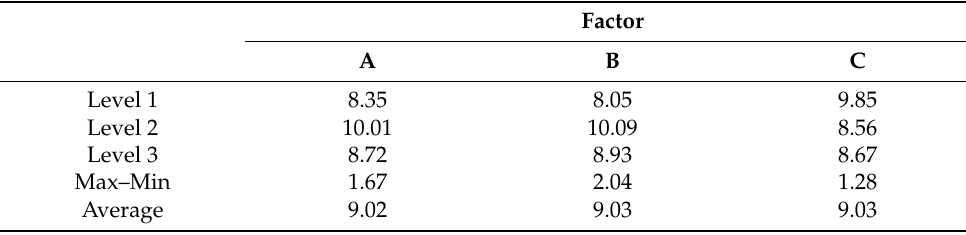
Figure 3. Surface texture of the sidewall of the microfluidic channel EP process with ( a ) 15 V, 15 vol.%, 10 mm; ( b ) 15 V, 20 vol.%, 20 mm; ( c ) 15 V, 25 vol.%, 30 mm; ( d ) 20 V, 15 vol.%, 20 mm; ( e ) 20 V, 20 vol.%, 30 mm; ( f ) 20 V, 25 vol.%, 10 mm; ( g ) 25 V, 15 vol.%, 30 mm; ( h ) 25 V, 20 vol.%, 10 mm; ( i ) 25 V, 25 vol.%, 20 mm. Table 8. Average S/N ratio by factor levels